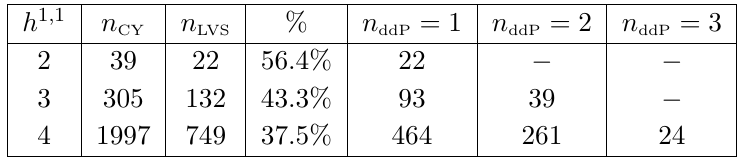
Table 1 . Number n of favorable CY geometries in the database of [56] for h 1 ; 1 = 2, 3, 4 and CY number n of LVS vacua classi(cid:12)ed in terms of the number n LVS